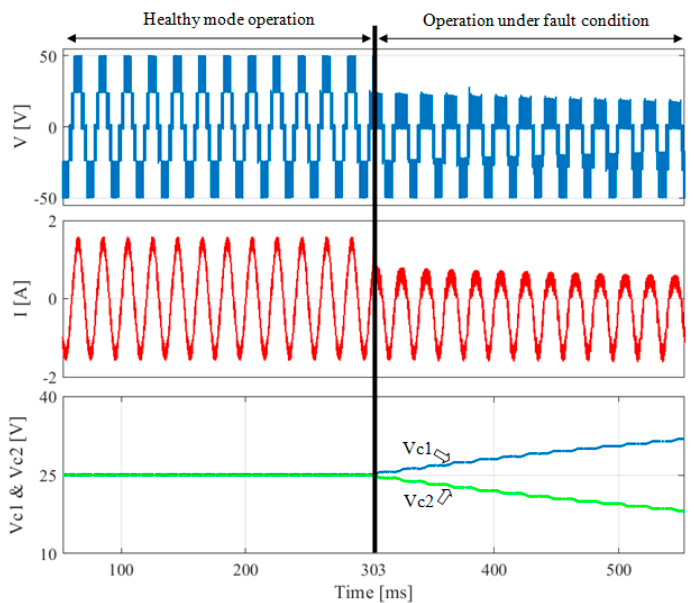
Figure 6. Simulation results of the inverter operation under open-circuit fault occurrence in S 11 , without fault-tolerant strategy.